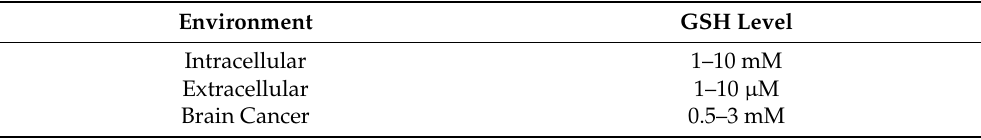
Table 3. GSH level for different cellular environments.